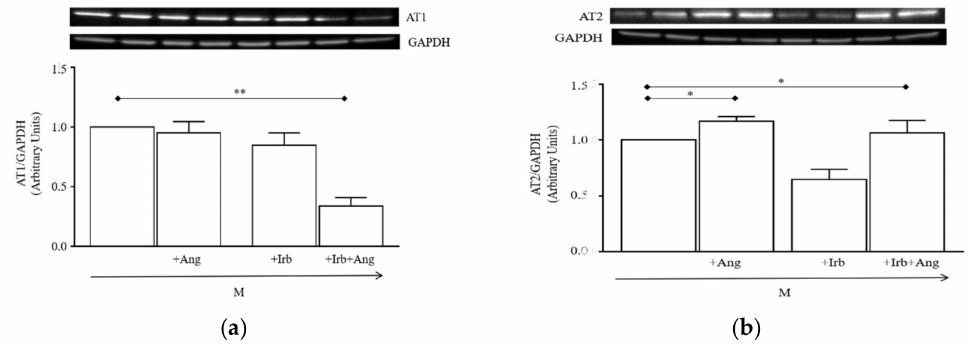
Figure 6. E ff ect of sub-chronic Ang conditioning of hSCs on expression of AT1 and AT2 receptors: ( a ) Representative immunoblotting (top) and densitometry analysis (bottom) of AT1 receptors expressed in hSCs cultured for 24 h in the M supplemented or not with 100 nM Ang, 1 µ M Irb, or Ang plus Irb (Ang + Irb); ( b ) representative immunoblotting (top) and densitometry analysis (bottom) of AT2 receptors expressed in hSCs cultured as in ( a ). Densitometry analysis is reported as ratios between the levels of the target protein and GAPDH. Results are presented as mean ± SEM of the three gels. * p < 0.05 vs. M, ** p < 0.01 vs.